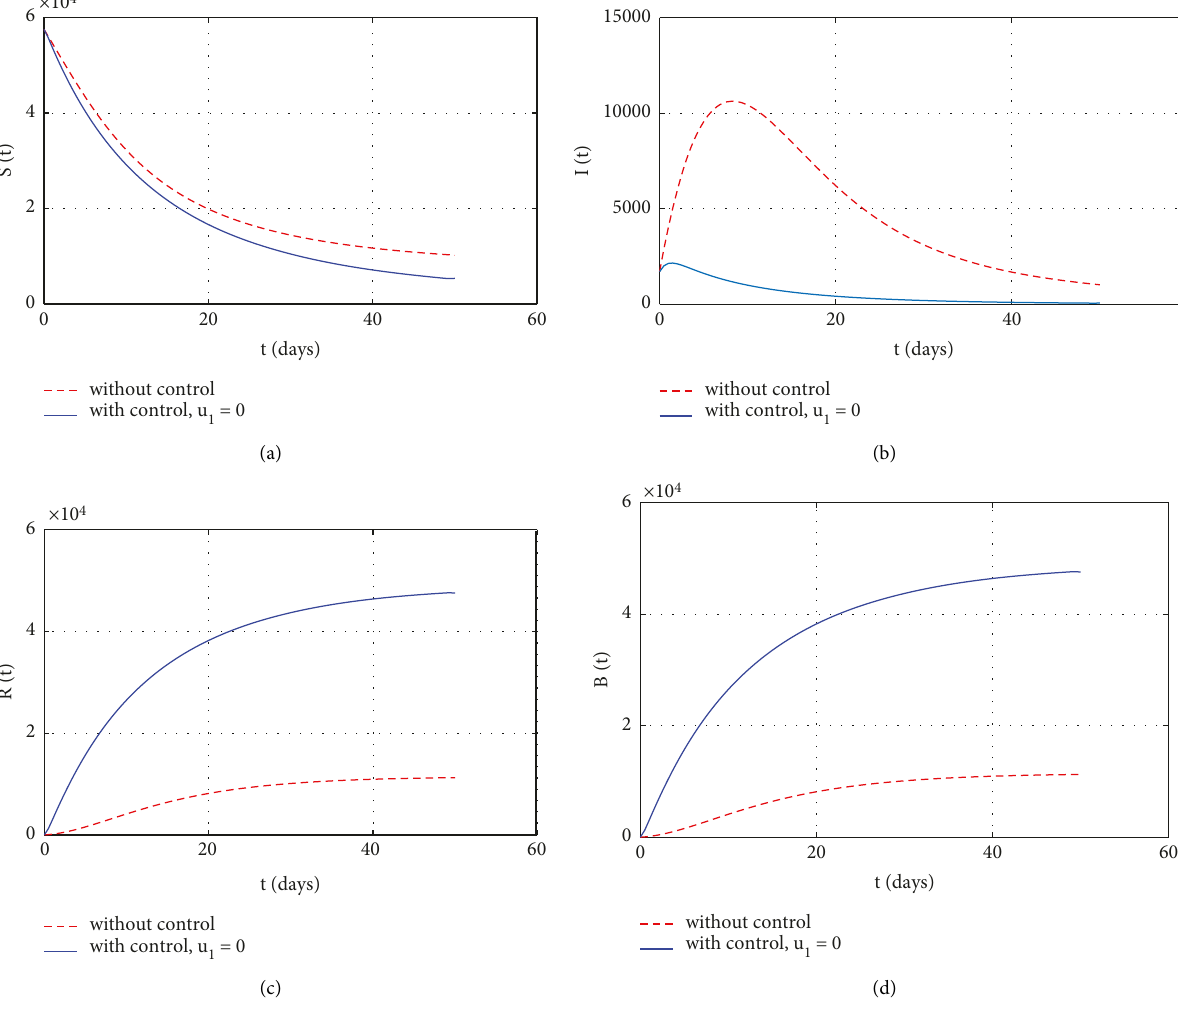
Figure 7: Numerical simulations of combination of vaccination, treatment of infective individuals, and